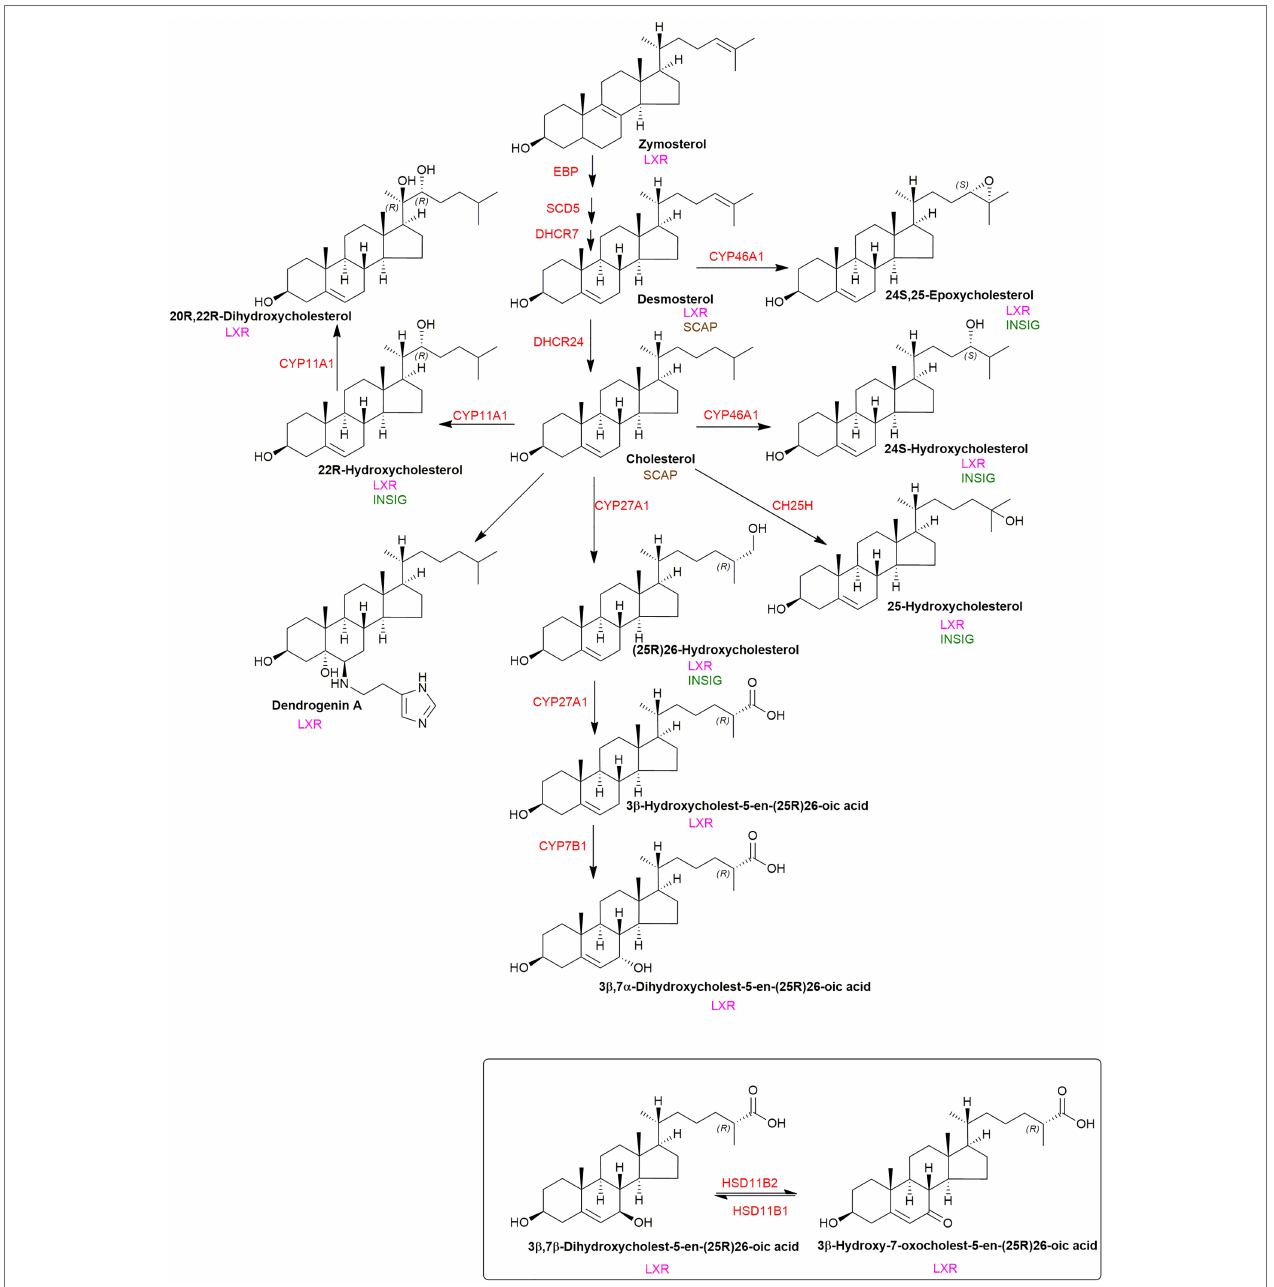
FIGURE 9 | Crosstalk between ligands to LXR, INSIG and SCAP. Enzymes are shown in red. LXR, INSIG and SCAP binding is illustrated where